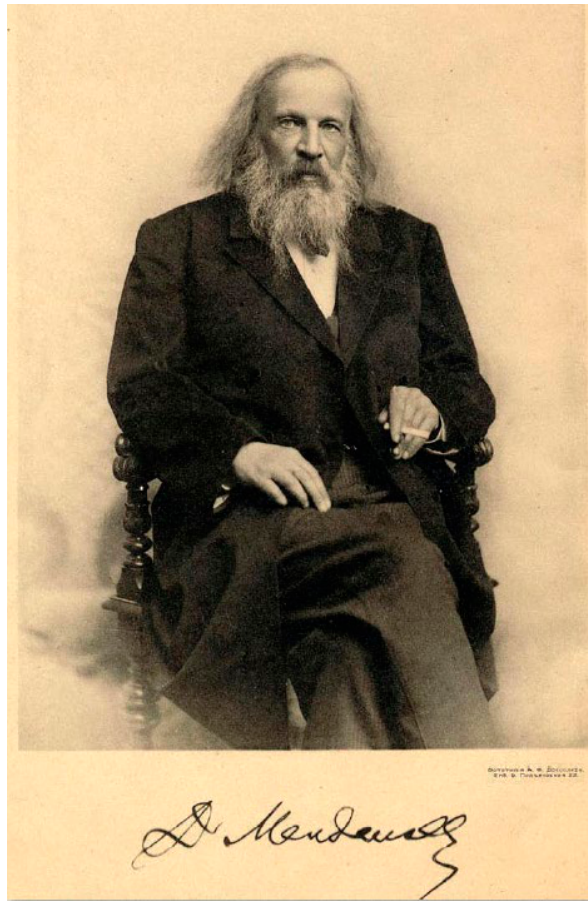
Figure 1. D.I Mendeleev (photo from public